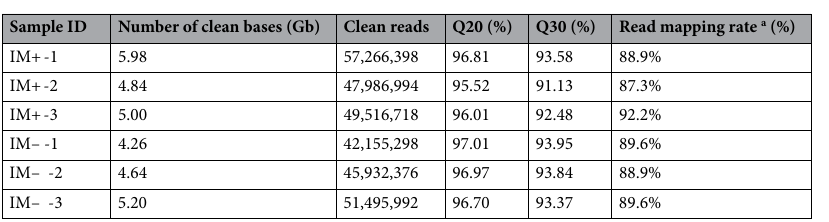
Table 1. Characteristics of the RNA-seq data from 6 chicken liver libraries. a Read mapping ratio, mapped reads/all